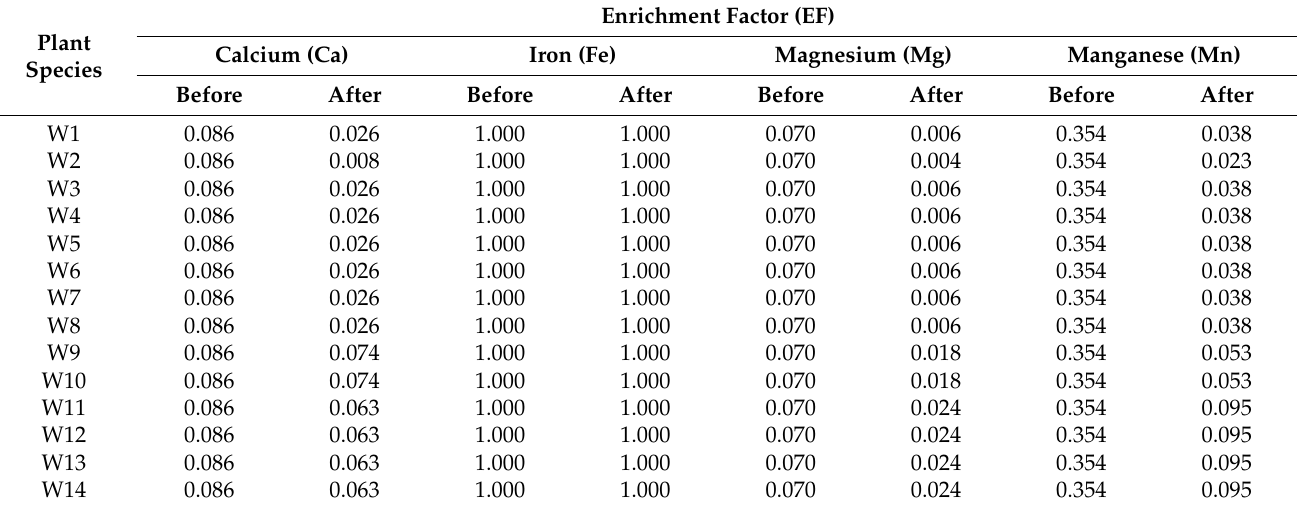
Table 5. Enrichment Factor (EF) for soil before and after phytoremediation of domestic sewage with various tropical plant species.